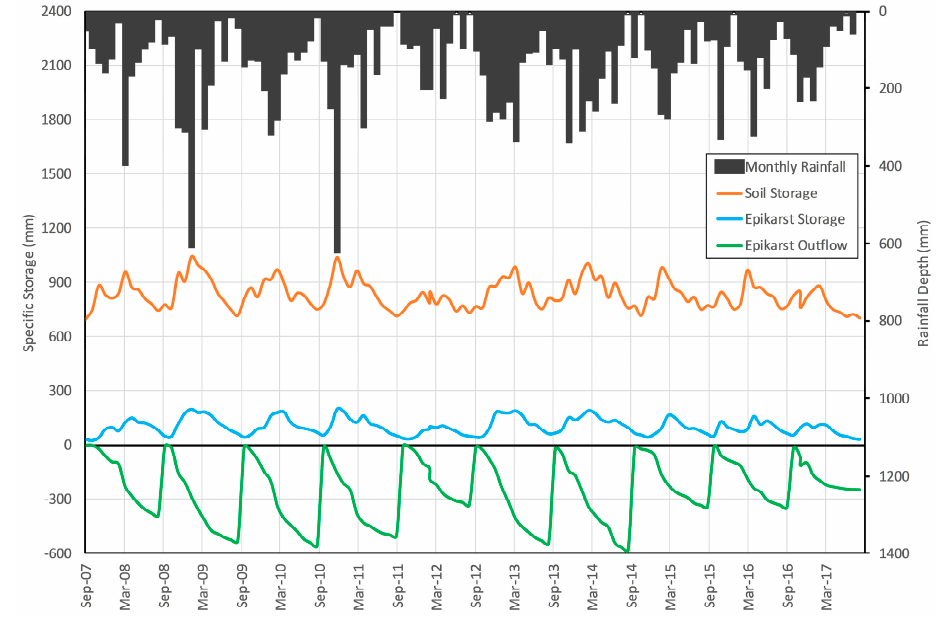
Figure 5. Specific water balance of the slope, estimated by means of the model, from 1 September 2017 till 6 June 2018.